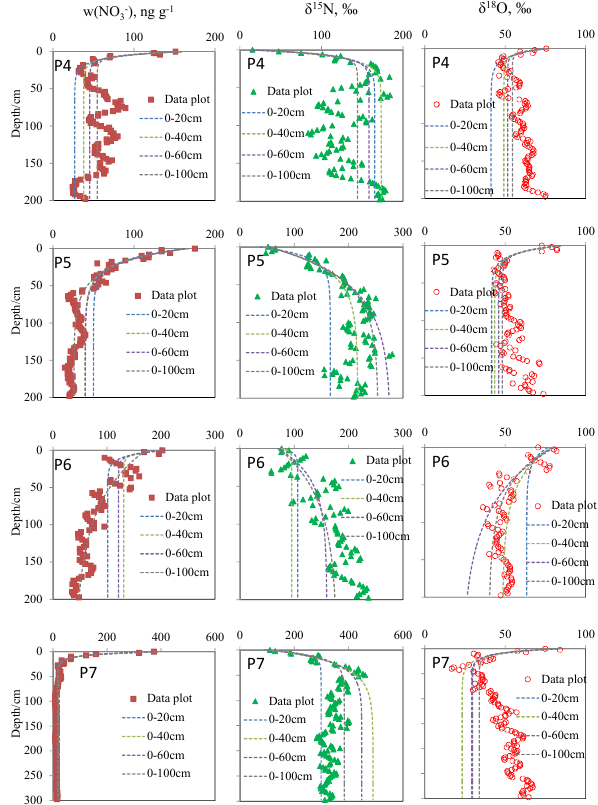
Fig. 6. Detailed profiles of w (NO 3- ), δ 15 N and δ 18 O of NO 3- in different snow depth intervals (0-20cm, ) , δ 15 N and δ 18 O of NO − Figure 6. Detailed profiles of w (NO − 3 3 0-40cm, 0-60cm, and 0-100cm) for the snowpits P4-P7. The dashed lines are the best fit regressions for the in different snow depth intervals (0–20, 0–40, 0–60, and 0–100cm) observed data, and asymptotic values are calculated for w (NO 3- ), δ 15 N and δ 18 O of NO 3- by Eq. (6). for the snowpits P4-P7. The dashed lines are the best fit regres- sions for the observed data, and asymptotic values are calculated ) , δ 15 N and δ 18 O of NO − for w (NO − by Eq. 3 3